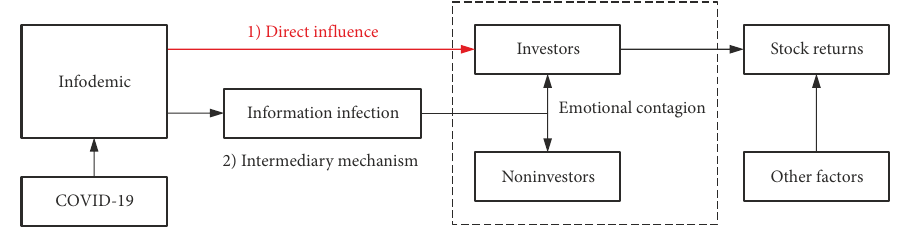
Figure 2. Influence mechanism of information epidemic on stock market